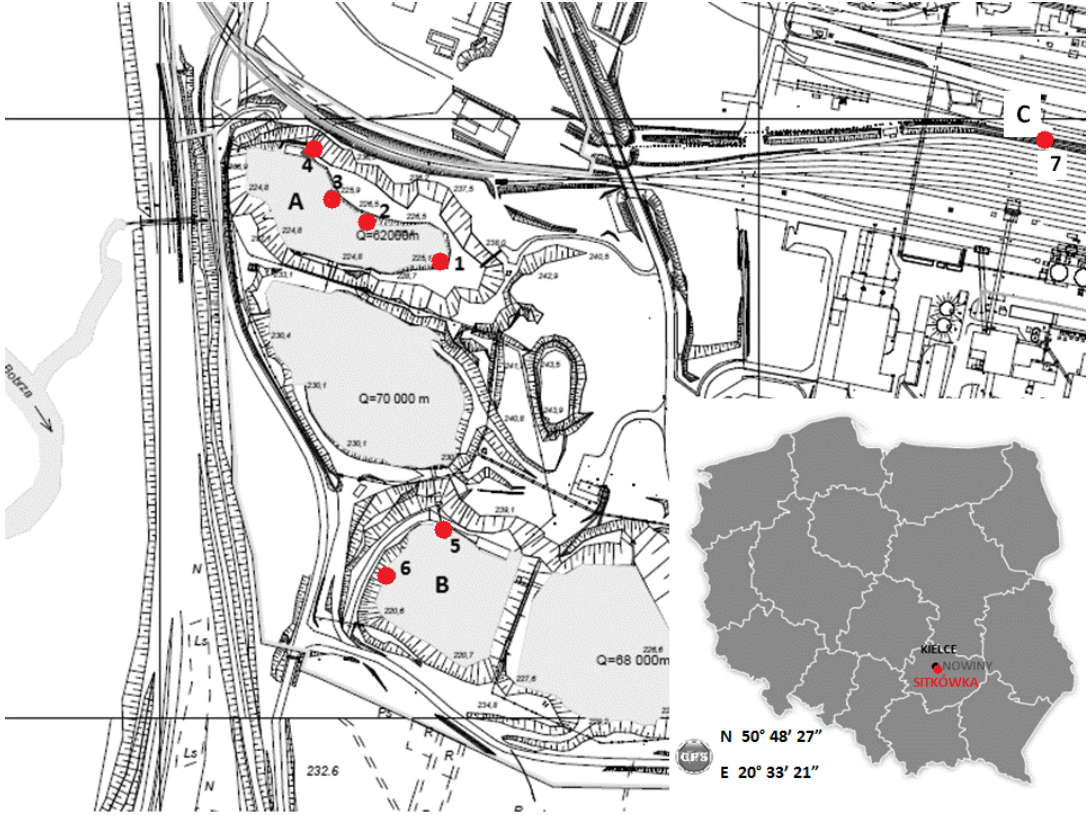
Figure 1: Location of sampling sites: water reservoir stocked with fish (A), reservoir of technological water (B), the drainage ditch of mining area